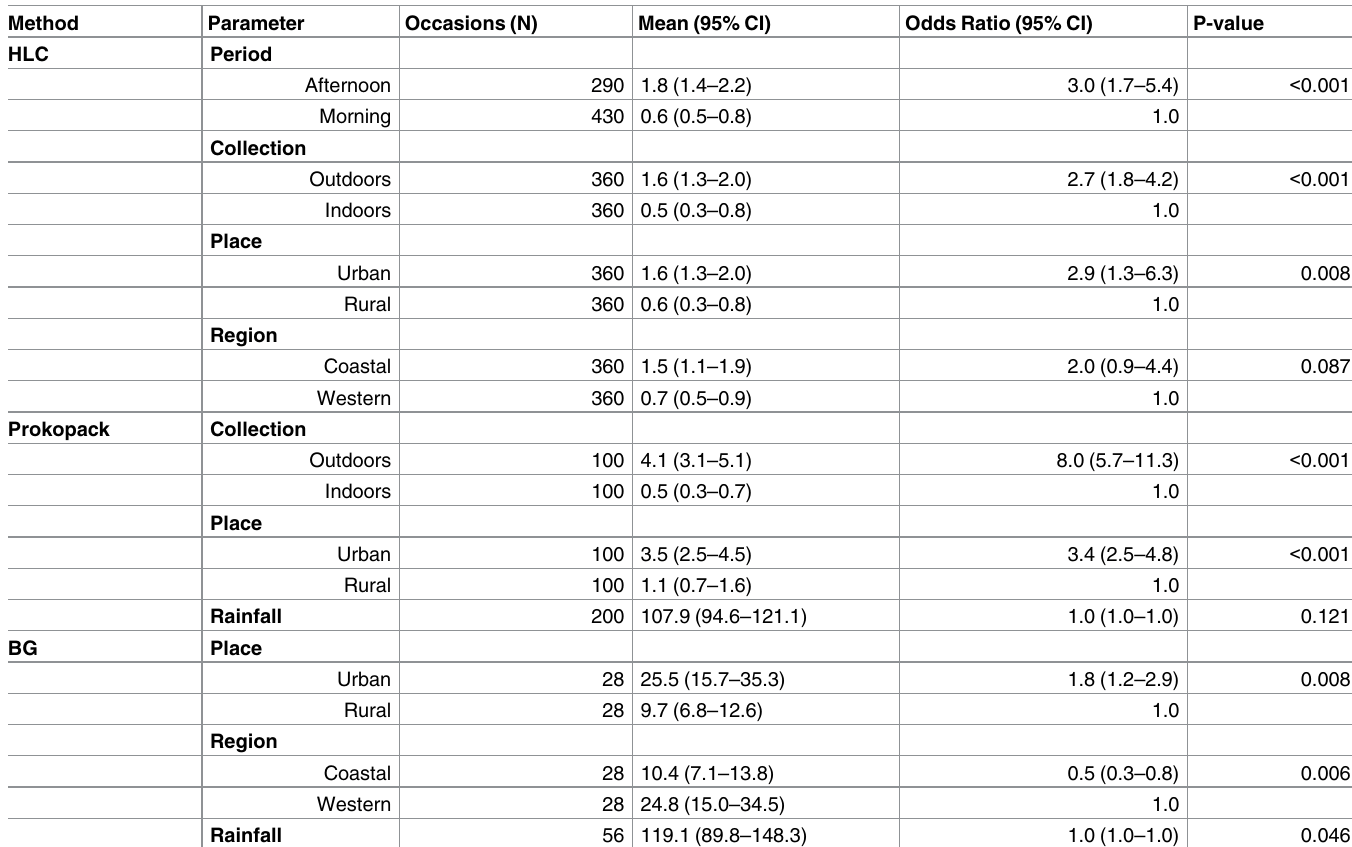
Table 1. Parameters associatedwith the abundance of Aedes aegypti mosquitoes collected by human landing catches, Prokopack aspirators and Bio-Gents sentinel